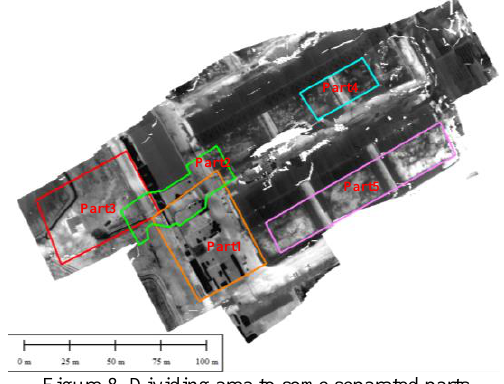
Figure 8. Dividing area to some separated parts.